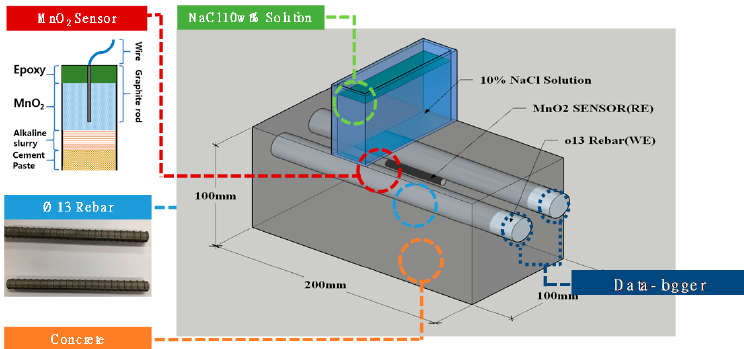
Figure 4. Schematic diagram of potential monitoring experiment according to NaCl supply time.